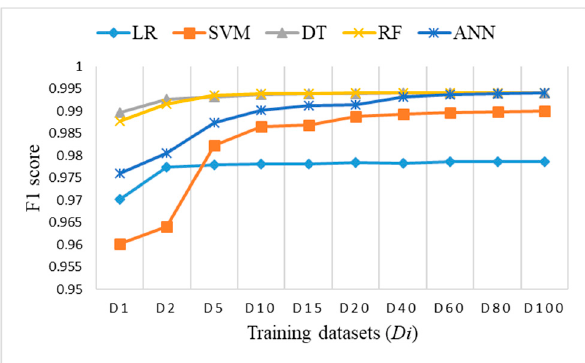
Figure 15. F1 score on test dataset for imbalanced datasets Di .